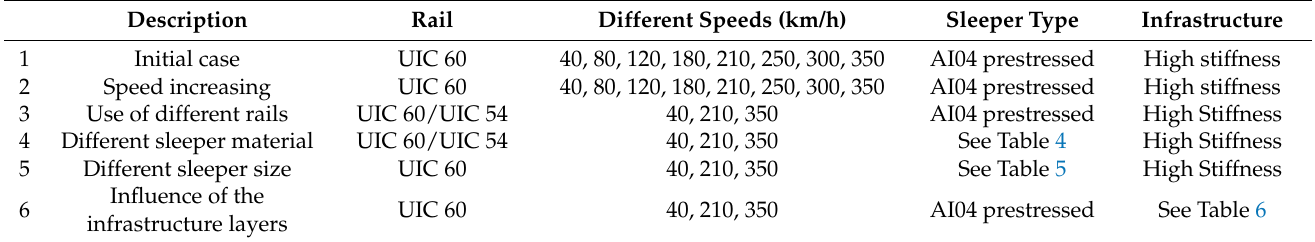
Table 3. Resume of the different analysed cases in this preliminary approach.